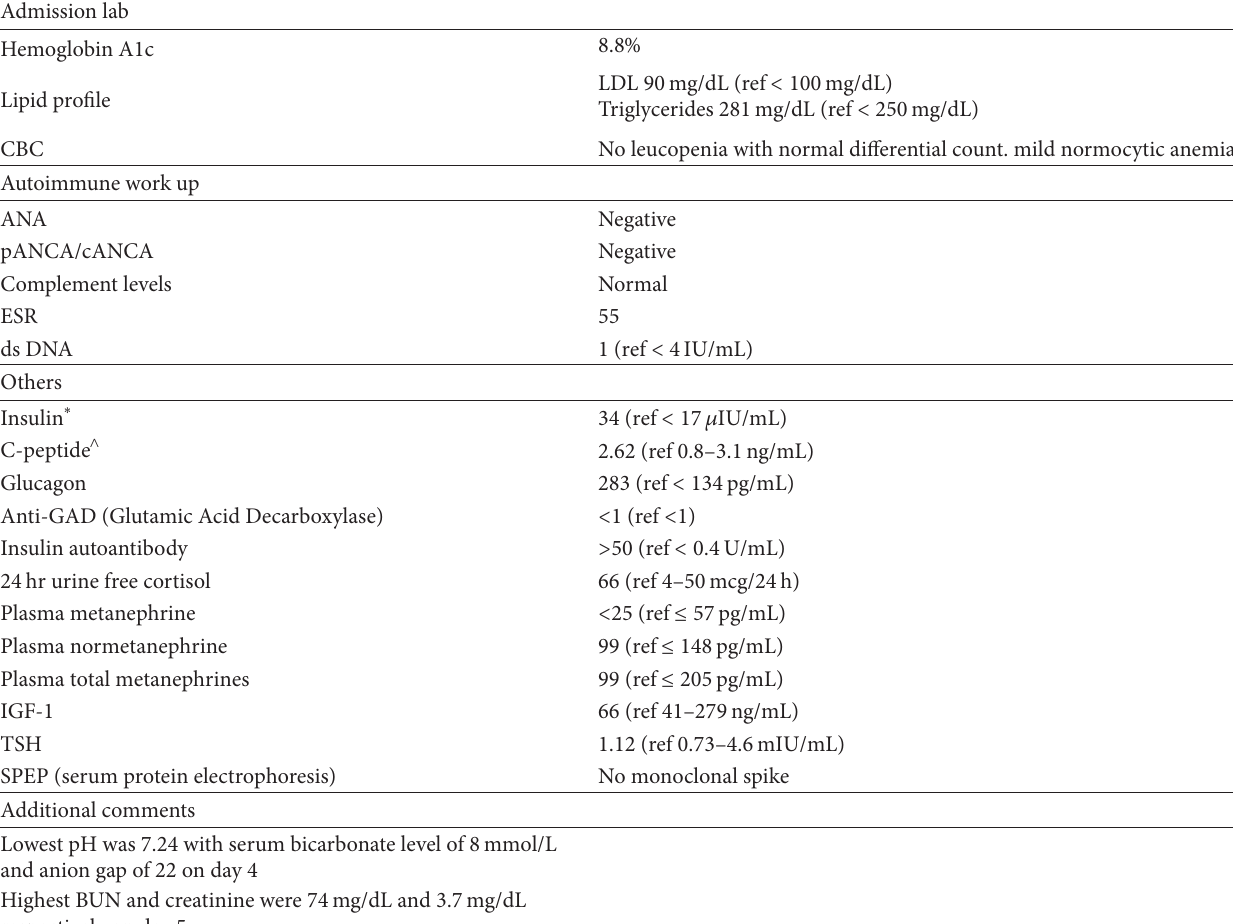
T 1: Results of relevant laboratory work